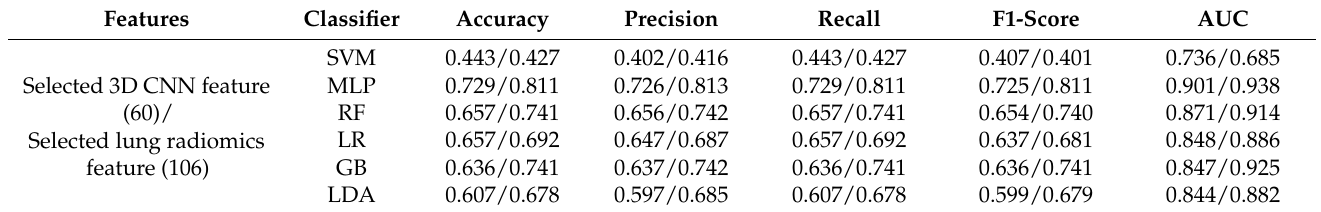
Table 4. The different ML classifiers’ performance on the test set of selected 3D CNN features (60) or lung radiomics features (106) generated by the GLM in Experiment 1.